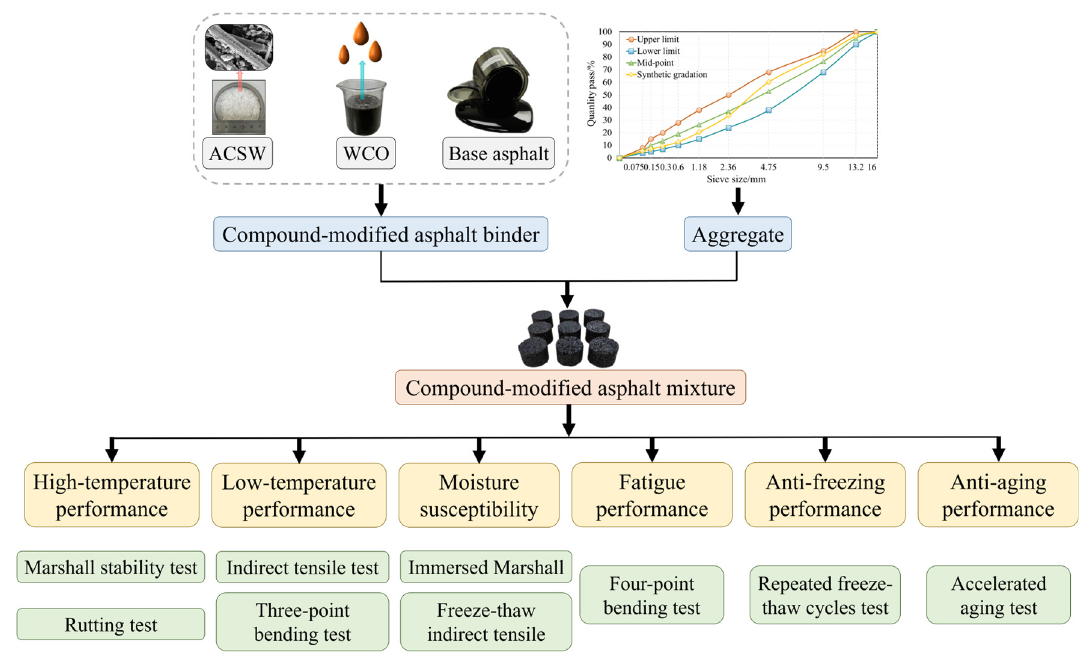
Figure 3. Materials and experimental processes.